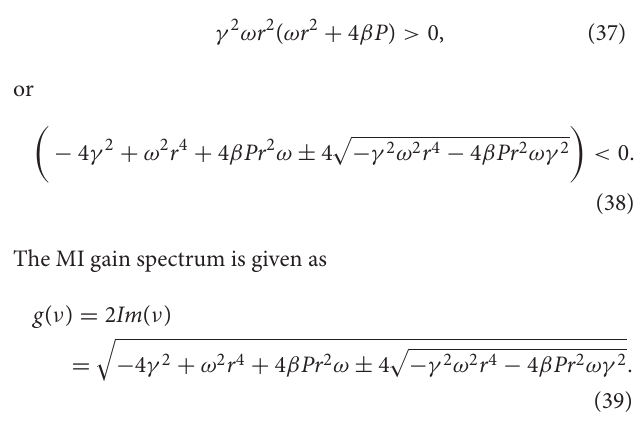
0.9, δ 0 ( t ) 0.001 t and α 5tan 2 (0.05 t ), (B) = = = 1.5 0.001cos t , δ 0 ( t ) 0.001 t and = + =